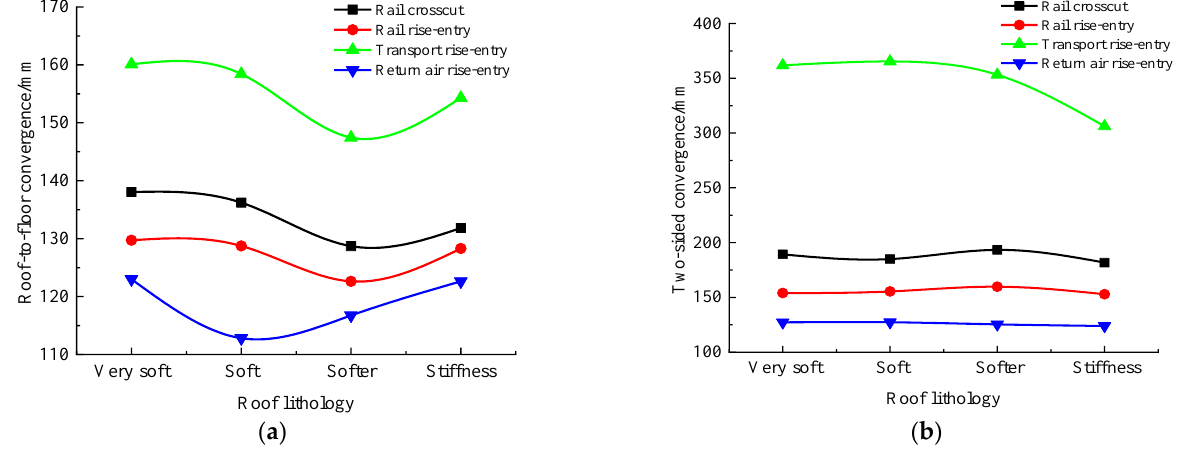
Figure 8. Monitoring results of convergence in roadway-concentrated areas under different roof lithology conditions. ( a ) Roof-to-floor convergence, ( b ) Two-sided convergence. It can be seen from Figure 8 that in the roof-to-floor convergence, affected by the roof lithology, each roadway showed a trend of decreasing first and then increasing. As for the two-sided convergence, the − 706-rail crosscut, rail rise-entry, and return air rise-entry were less affected by the lithology of the roof, and only the transport rise-entry showed a decreasing trend. Overall, when the roof lithology was stiff, the − 706-rail crosscut, rail rise-entry, transport rise-entry, and return air rise-entry roof-to-floor convergence compared to the lithology was very soft, and decreased by 4.49%, 1.1%, 3.63%, and 0.3%, while the two-sided convergence was reduced by 4.01%, 0.7%, 15.37%, and 2.61%, respectively.